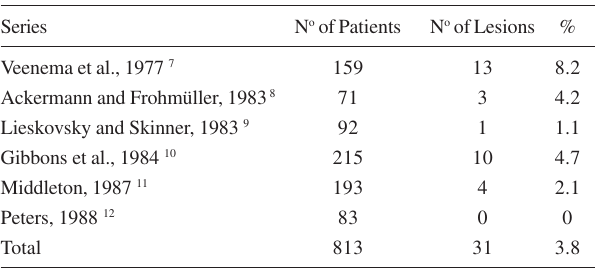
Table 2 - lncidence of rectal lesions in radical